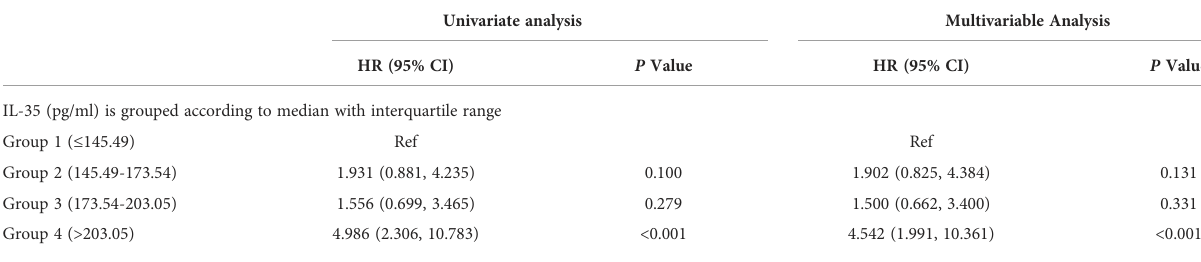
TABLE 3 Cox regression analysis for remission time in IMN patients (IL-35 for categorical variables).